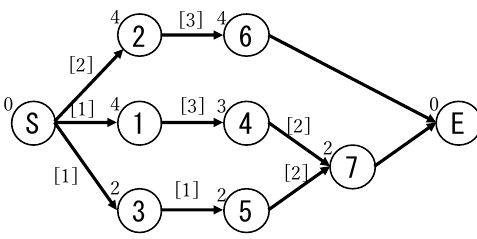
Figure 3. Re-numbered task graph in Figure 1.